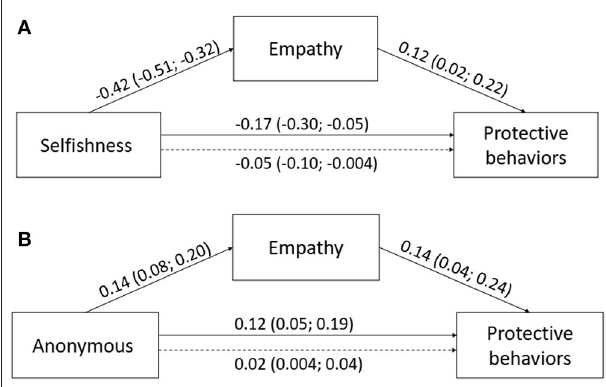
FIGURE 1 | Mediation effect of empathy in relations between selfishness (A) and anonymous prosociality (B) with protective behaviors. Unstandardized beta coefficients and 95% CIs were presented. Betas below dotted line refers to indirect